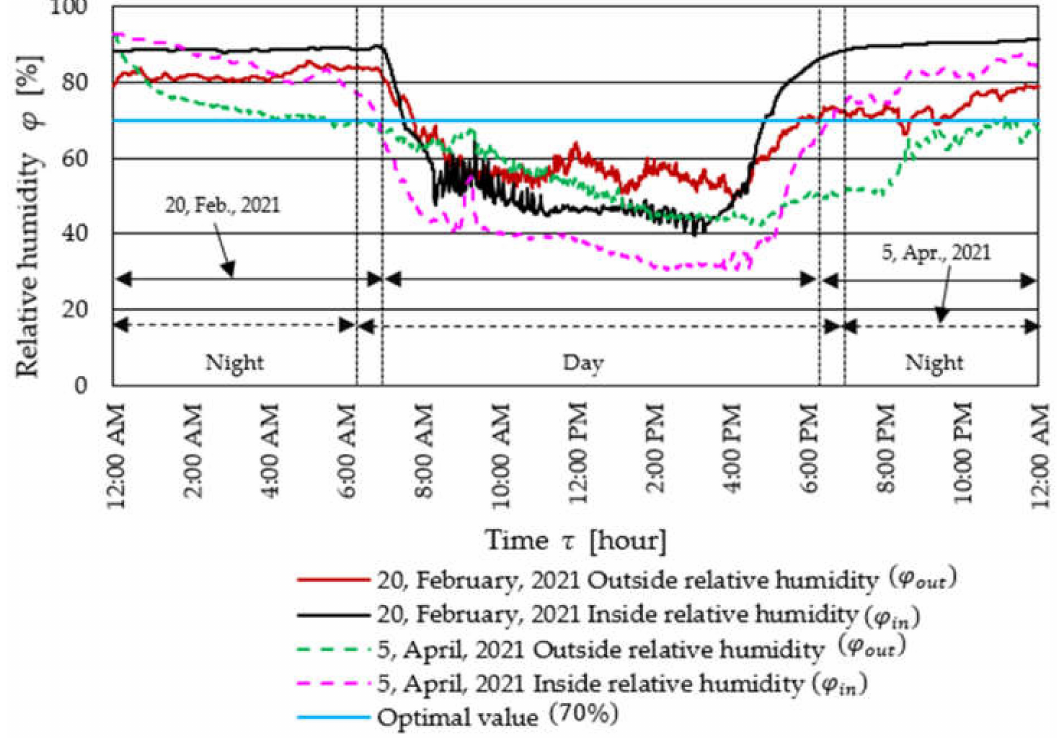
Figure 11. Variation in relative humidity inside and outside the greenhouse on each